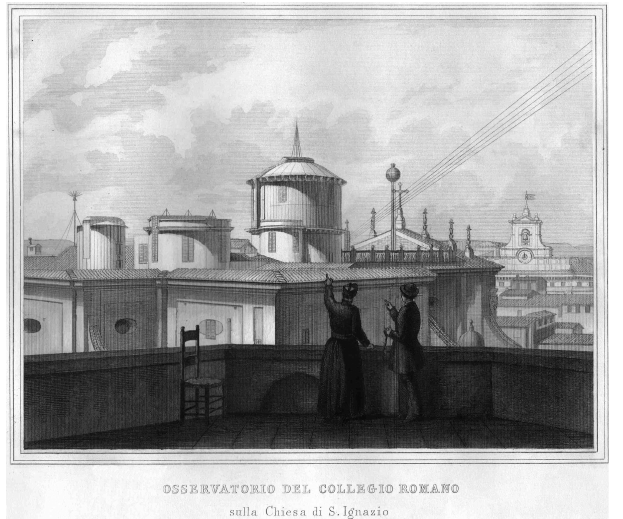
Figure 3. Period etching of the Collegio Romano Observatory on the roof of the church of Sant’Ignazio (from Cacchiatelli and Cleter, 1863).